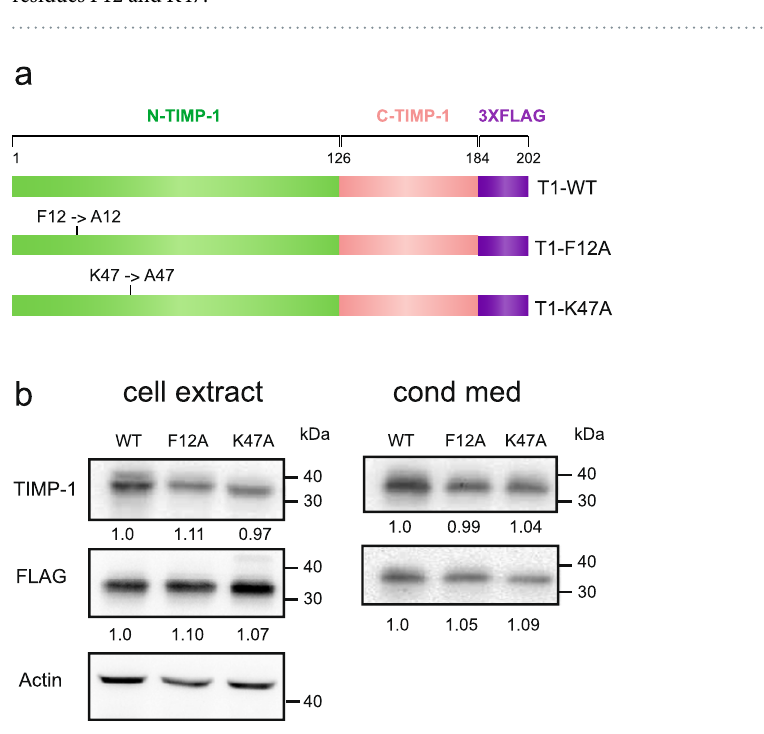
Figure 4. Production of TIMP-1 mutants. ( a ) Schematic representation of T1-WT, T1-F12A and T1-K47A proteins. ( b ) A representative western blot with the indicated antibodies of cell extracts and conditioned medium (cond. med) of stably transfected CHO cells with p3X-FLAG-CMV-14 expressing T1-WT, T1-F12A or T1-K47A. The relative protein level based on three independent experiments is indicated under each band. The gels were run under the same experimental conditions and were shown as cropped gels/blots (Cropped gels/ blots are shown in Supplementary Figure S1).